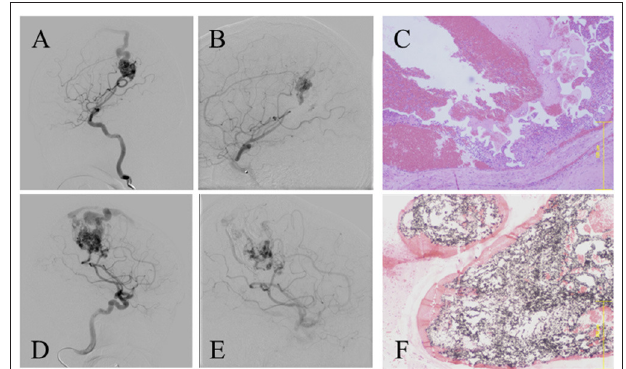
FIGURE 1 | (A,B) Lateral projection digital subtraction angiogram (DSA) showing Spetzler-Martin grade 1 AVM pre-embolization and post embolization using NBCA, respectively. The calculated embolization rate was 68.8%. (C) pathological findings of resected angiographically disappeared nidus showing remarkable red blood cells in the microvasculatures (Hematoxylin-Eosin staining, × 25). (D,E) Lateral projection DSA showing Spetzler-Martin grade 3 AVM pre-embolization and post embolization with Onyx, respectively. The calculated embolization rate was 52.1%. (F) Pathological findings of resected angiographically disappeared nidus showing the Onyx cast without red blood cells in the microvasculatures (Hematoxylin-Eosin staining, × 25). AVM, arteriovenous malformation; NBCA, N -butyl